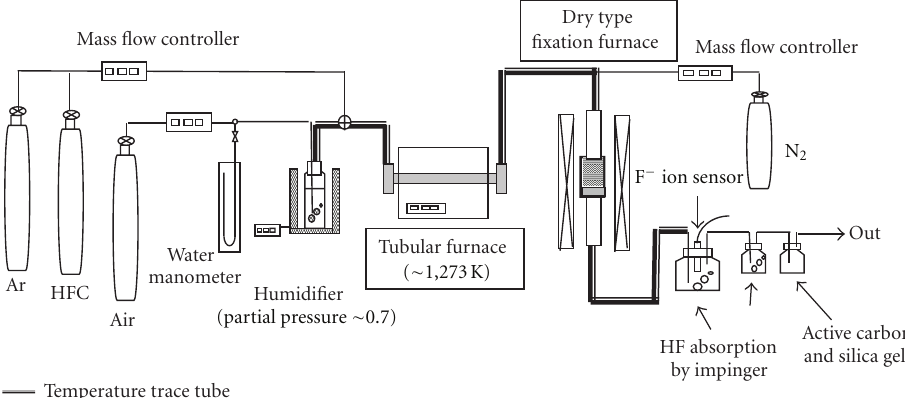
Figure 6: Experiment flow of the gas-solid reaction of HF and CaCO 3 .